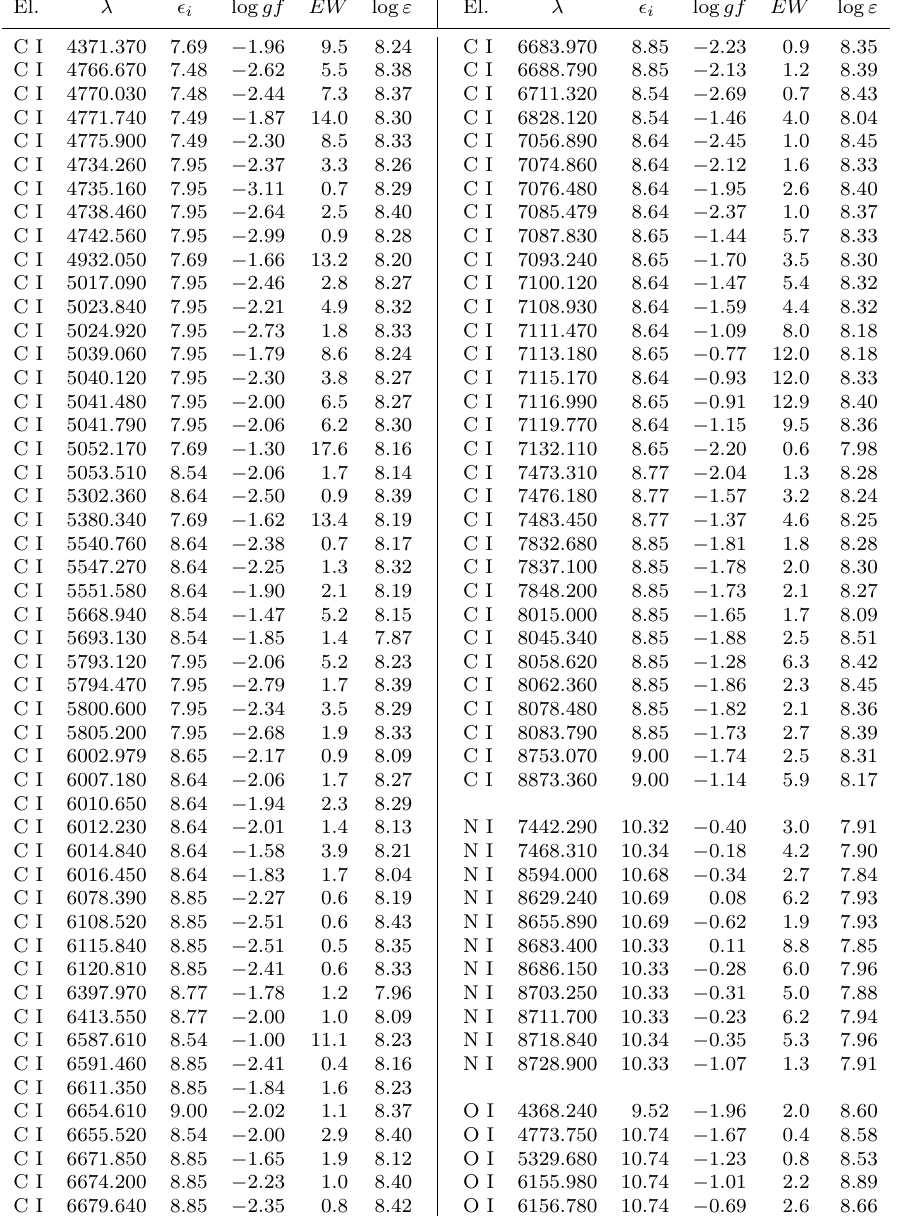
Table 4. Atomic data (wavelengths [(cid:23)A], lower level excitation potentials ϵ i [eV], oscillator strengths log gf ), equivalent widths [pm] and abundances calculated with the model parameters T eff = 6000 K, log g = 0 . 5 and ξ t = 6 . 8 km s − 1 for HD 52961.